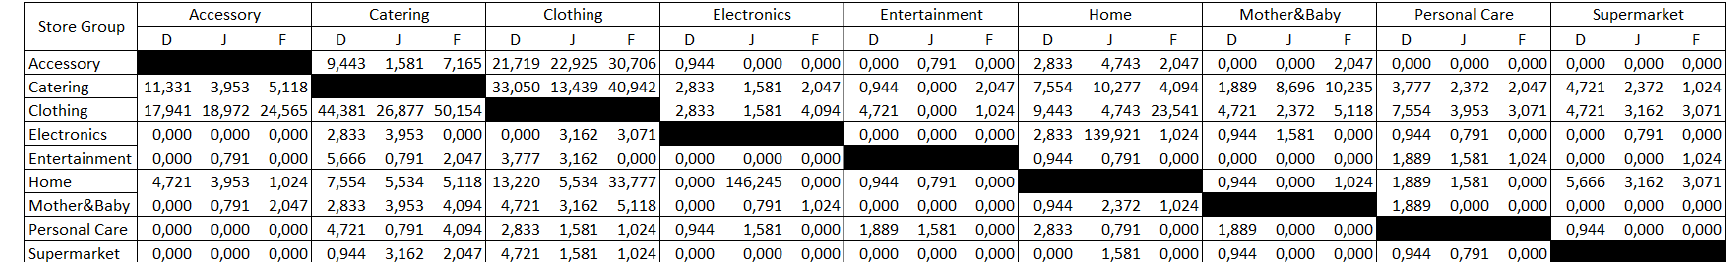
Figure 9. Probability matrix of transitions of female customers ( × 10 − 3 )